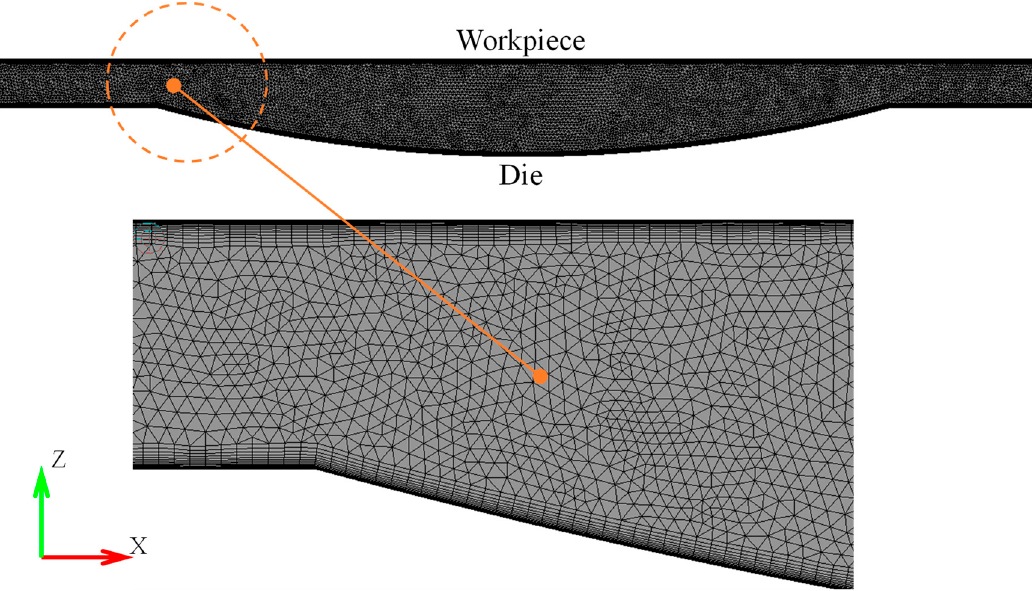
Figure 8. Computational mesh of fl uid domain with micro-pocket textured surface.